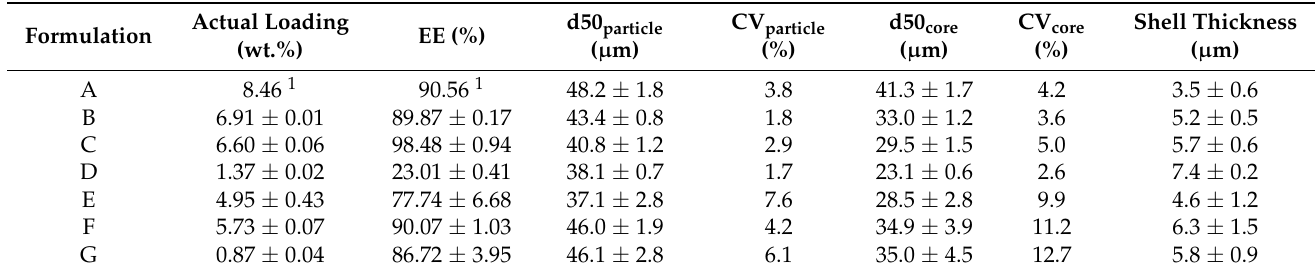
Table 2. Characteristics of BSA-loaded core-shell microspheres of different grades of poly(DL-lactide- co -glycolide) (PLGA) and theoretical loading.